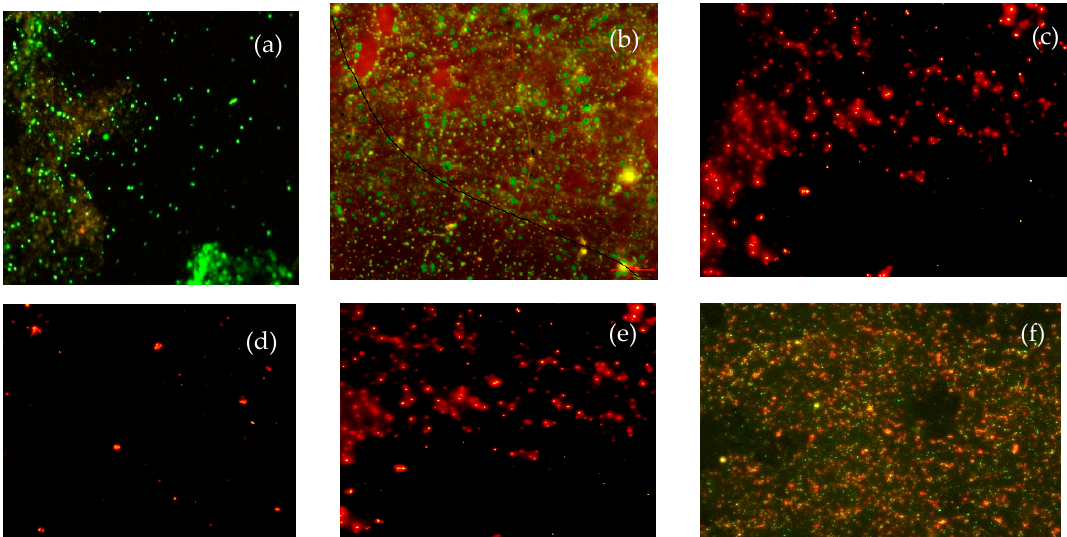
Figure 2. Viability of pathogenic and spoilage microorganisms contacted with coating without microencapsulated mixture of EOs (CC), or coating with microencapsulated mixture of EOs (AC). ( a ) control of intact viable cells ( Ps. fragi ); ( b ) B. thermosfacta contacted with CC. Bacteria after contact with AC: ( c ) B. thermosfacta; ( d ) L. plantarum; ( e ) E. coli O157:H7 ; ( f ) Ps. fragi .